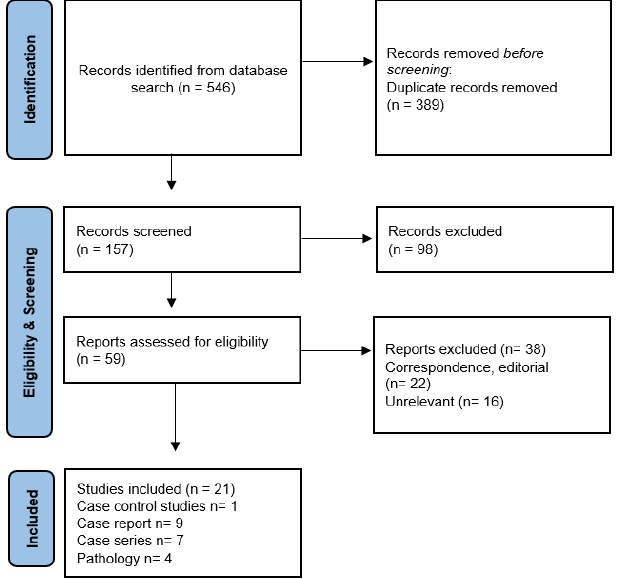
Figure 1. PRISMA 2020 flow diagram showing the search strategy in this systematic review.